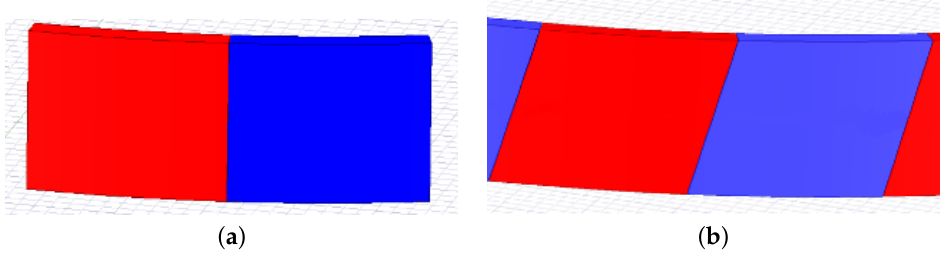
Figure 3. 3D models of the ( a ) nonskewed and ( b ) skewed